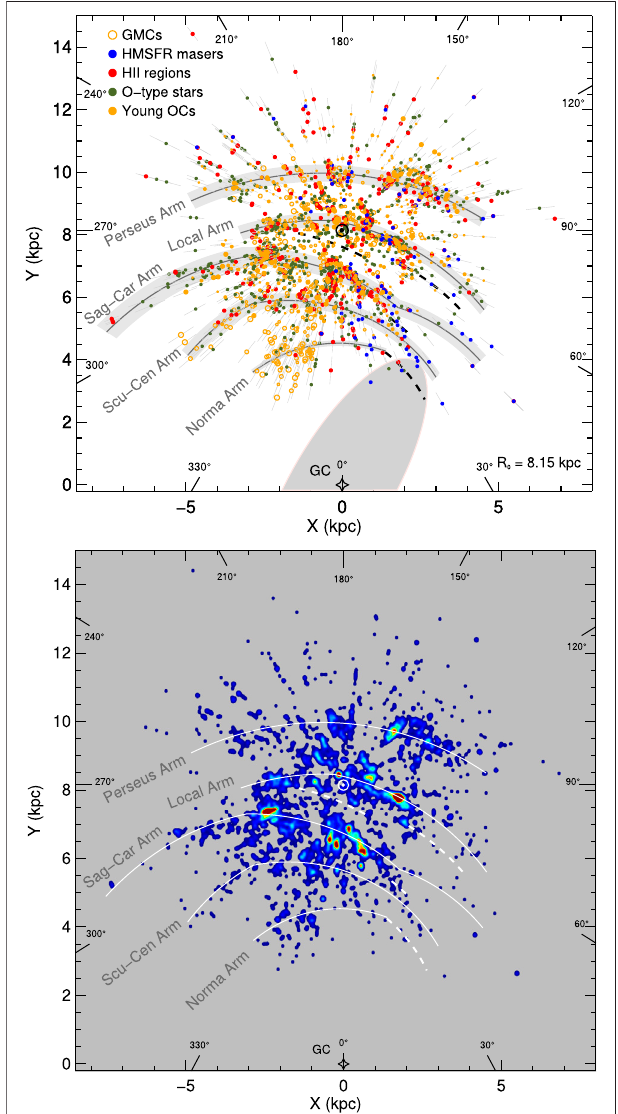
FIGURE 3 | Upper : Distributions of the combined dataset of GMCs, HMSFR masers, HII regions, O-type stars, and young OCs in the Galactic disk. For all the plotted sources, their distance uncertainties are better than 15% and smaller than 0.5 kpc. The positional uncertainty for each data point is shown by an underlying gray line segment. The curved solid lines indicate the best fi tted spiral arm model given by this work ( Table 1 ). The shaded areas around spiral arms denote the fi tted arm widths. The four dashed lines are the spurs or spur-like structures proposed in literature. Lower : Similar to the Upper panel, but a “ density ” distribution is calculated according to the distribution of the